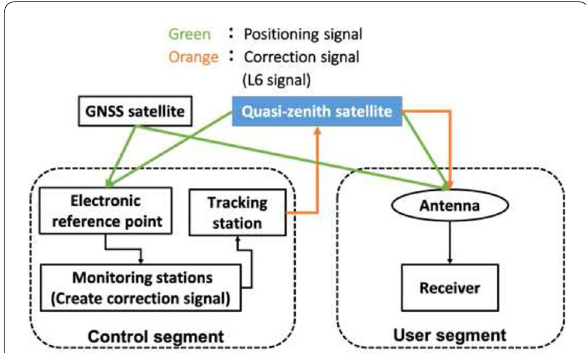
Fig. 7 Flow of centimeter-level